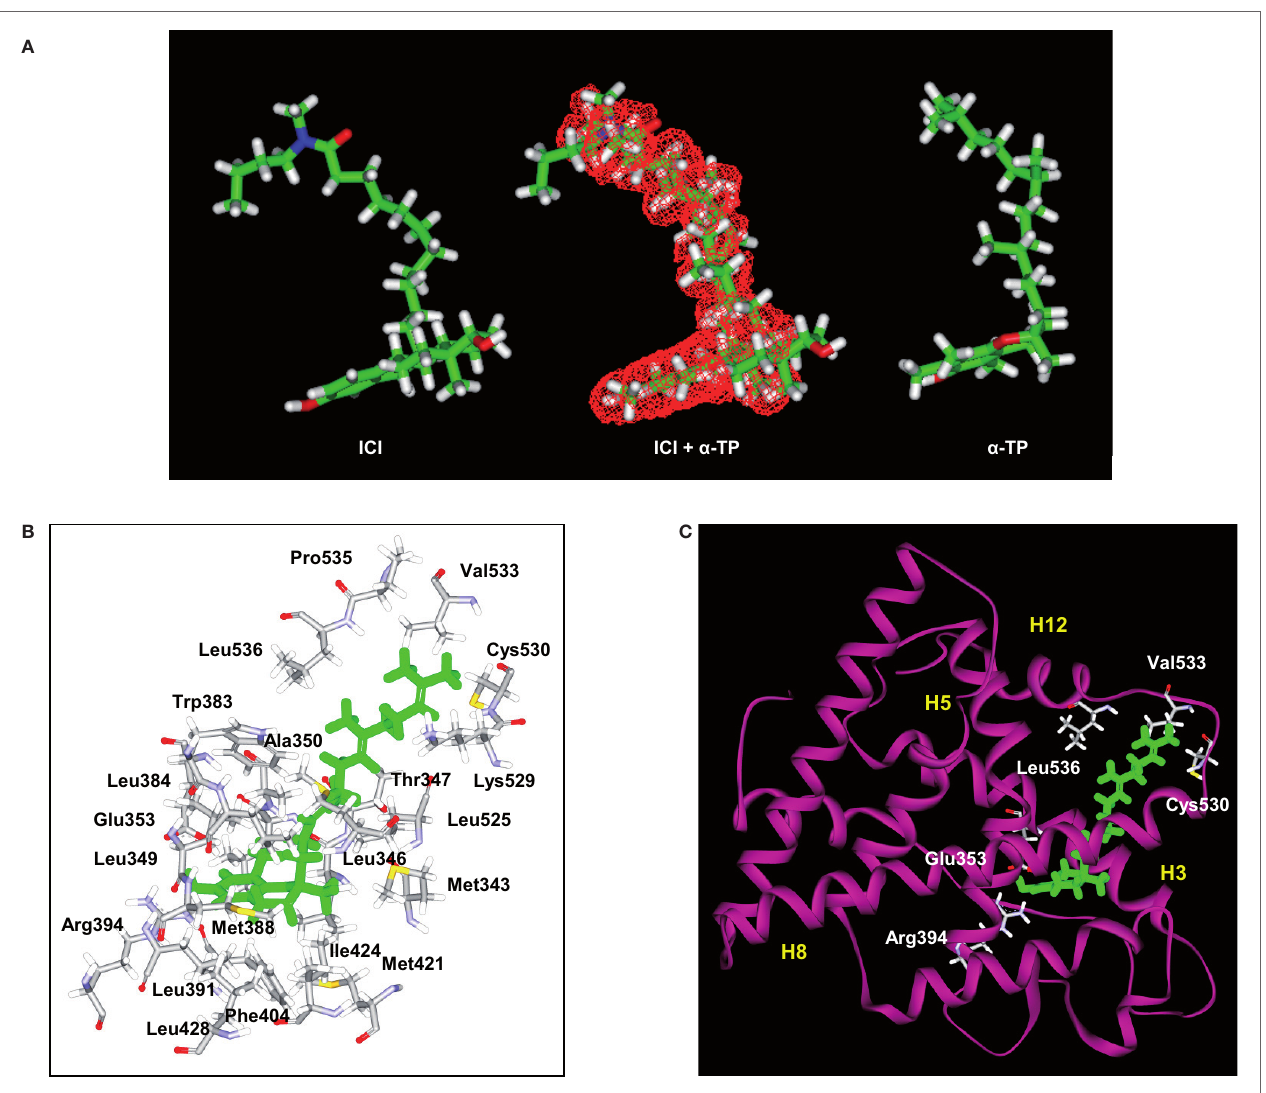
FigUre 2 | structural analyses of α -TP alone and δ -TP docked with er α . (a) Three-dimensional structures of the conformations of ICI 164,384 (ICI) (left), taken in the crystallographic structure of rat ER β -ICI 164,384, and the calculated minimal energy conformation of α -tocopherol ( α -TP) (right). The calculated minimal energy was carried out using the Discover module of Insight II (version 2000), as described in Section “Materials and Methods.” An overlay of α -TP and ICI (center), as well as van der Waals volume calculations and intersection measurements, was carried out using the Search-Compare module. The van der Waals volume intersection is depicted as the red grid and illustrates the structural similarities between α -TP and ICI. The van der Waals volumes of α -TP and ICI are 406.57 and 468.77 Å 3 , respectively. Sixty-three percent of the van der Waals volume of α -TP is in common with that of ICI. (B) Amino acids that interact with δ -TT: cross- sectional view of δ -TT within the ER α ligand-binding domain. Green: δ -TT; gray: carbon atoms; white: hydrogen atoms; red: oxygen atoms; blue: nitrogen atoms; and yellow: sulfur atoms. (c) Ribbon representation of the molecular model of δ -TT bound to ER α . δ -TT is drawn in stick form and colored in green. Helical elements of the ER are numbered (H3, H5, H8, and H12) and colored in